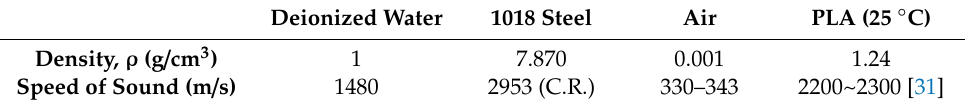
Table 2. The material properties for deionized (DI) water, air, the PLA material, and 1081